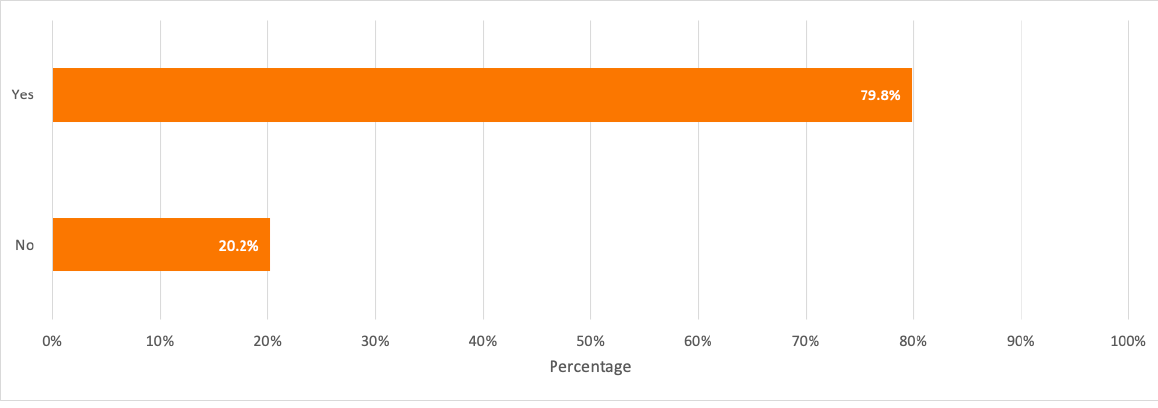
Figure 10. Respondents ’ interest/willingness in participating in e-waste recycling.